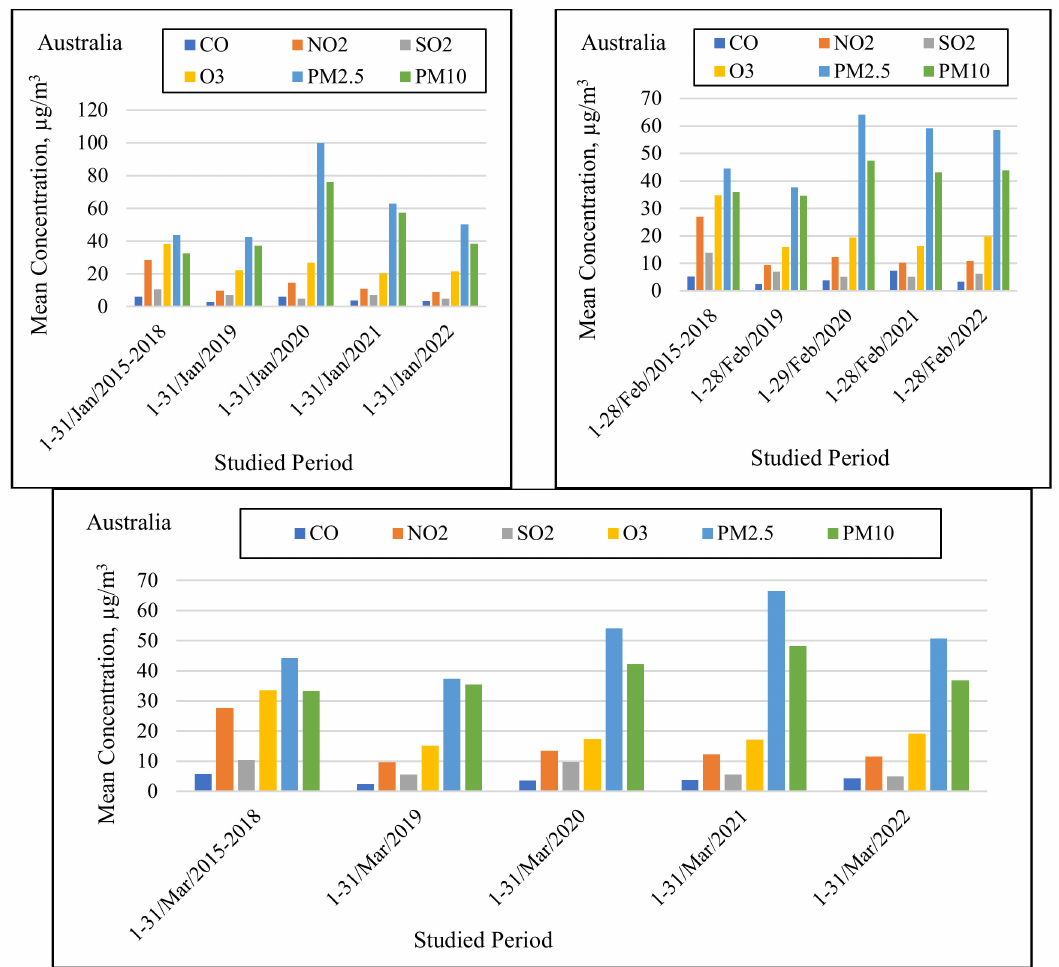
Figure 5. Average concentrations of air pollutant in a country of the Oceania geoeconomic